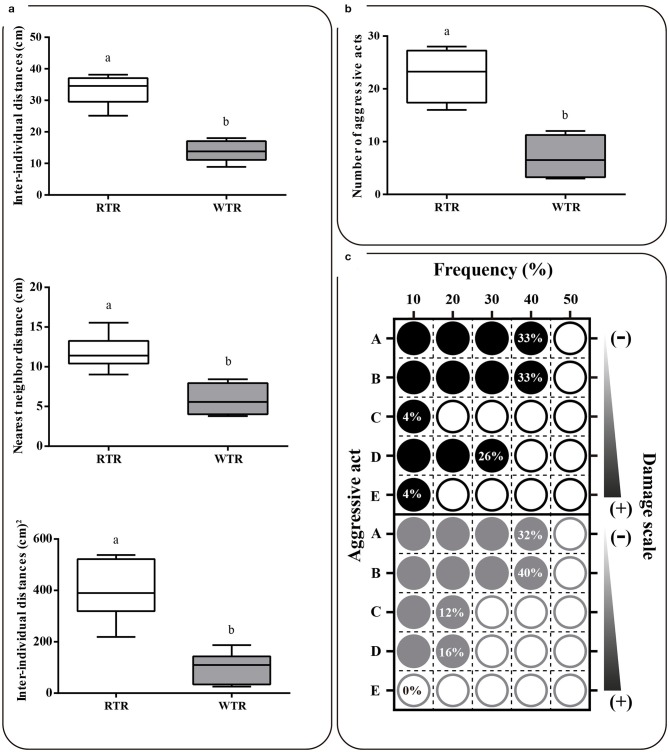
Effect of thermal range in behavioral of Salmo salar. (a) Nearest neighbor distances, inter-individual distances, and variance of interindividual distances. (b) Number of aggressive acts (c) Matrix plots registered differences in frequency (%) and potential damage of each aggressive act. Behavioral patterns observed and counted as one aggressive act were: (A) chasing without nipping or biting, (B) nipping without prior chasing, (C) biting without prior chasing, (D) chasing that ended up as nipping and (E) chasing that ended up as biting. The experimental groups are: restricted thermal range (RTR, ΔT 1.4°C) and wide thermal range (WTR, ΔT 6.8°C). Different letters denote significant differences between groups (Two-tailed Student's t-test; p < 0.05).